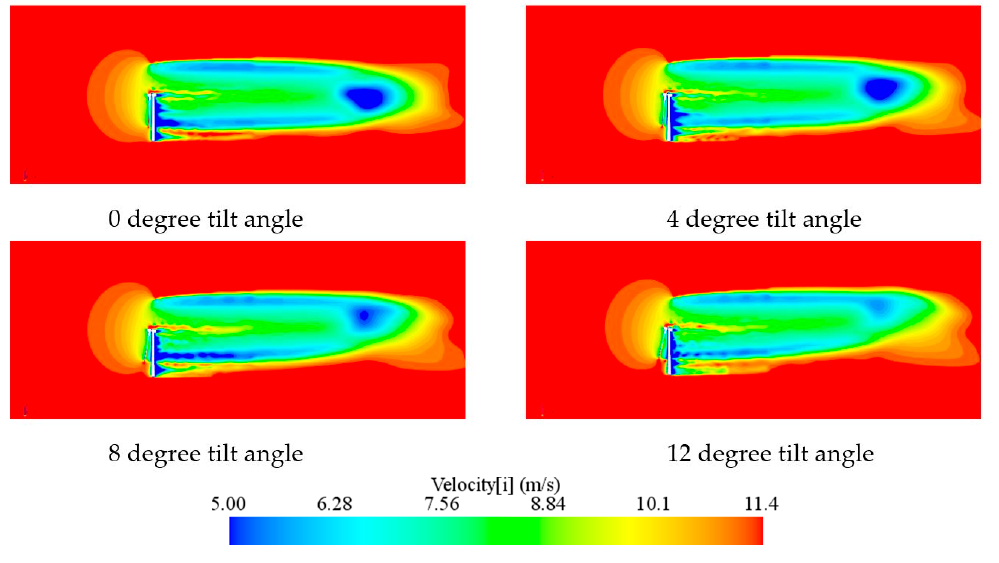
Figure 21. Vertical section x-velocity profiles at y = 0 m.